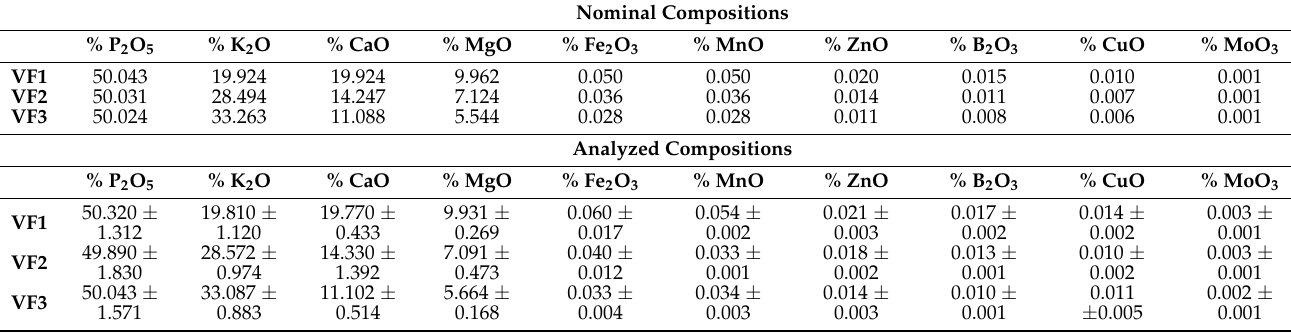
Table 1. Nominal and analyzed compositions for concentrations of [K 2 O/(CaO+MgO)] ratio (%mol). VF1: 0.67 %mol, VF2: 1.33 %mol and VF3: 2 %mol. Nominal